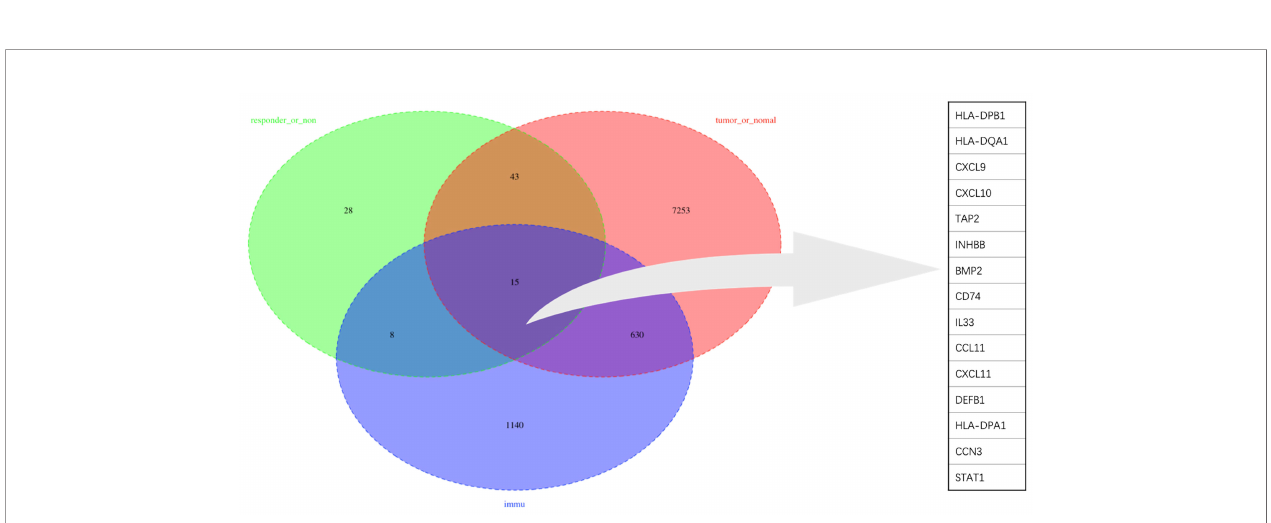
FIGURE 3 | Identi fi cation of DEGs between rectal responder (R) subgroup and non-responder (NR) subgroup. (A) Principal component analysis (PCA) of expression level of rectal responder (R) subgroup and non-responder (NR). (B) Volcano plot and (C) hot map illustrating differentially expressed genes (DEGs) between rectal responder (R) subgroup and non-responder (NR).